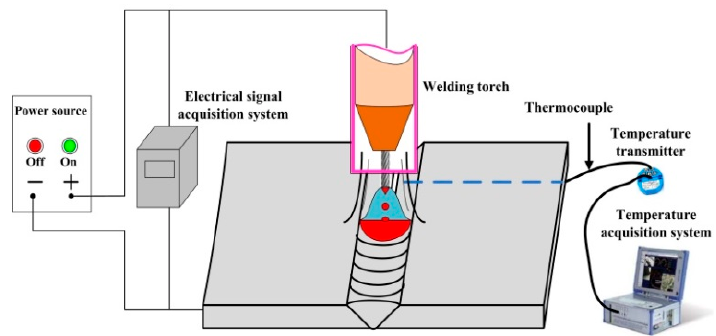
Figure 2. Schematic diagram of the welding trials. Table 1. Chemical compositions of the base metal, welding wires, and weld seams.